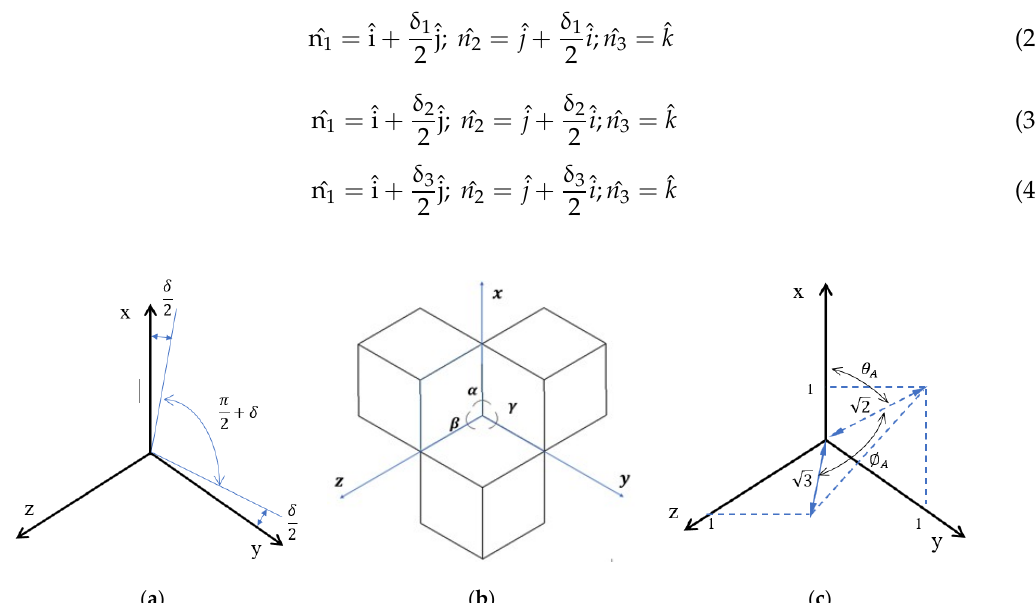
Figure 3. ( a ) The dihedral-angle offsets; ( b ) the angle between each plane; and ( c ) the symmetry axis direction.